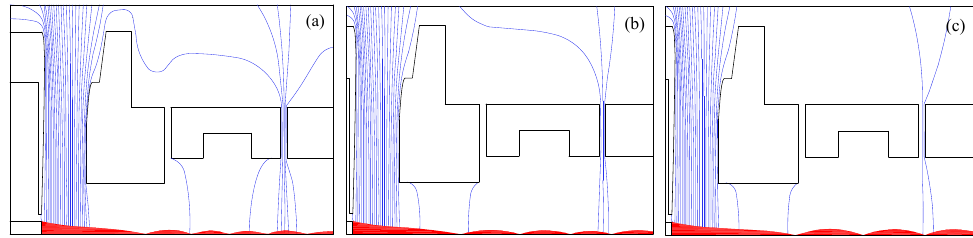
Figure 2. Simulated trajectories (red) and equipotential lines (blue) for an electron beam with an energy E of: ( a ) 11.5 keV; ( b ) 15 keV; ( c ) 25 keV. Electron current I = 20 mA in all cases. Part of the drift tube section with an enlarged diameter corresponds to the area under radiation